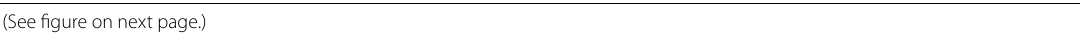
of variable appearance. Figure 9C (left) depicts gray angu- lar blocks in a whitish matrix. The majority of the blocks measure less than 1 m. The matrix consists of commi- nuted limestone with a grain size 2 mm. The rock is a ≤ matrix-supported breccia and corresponds to a catacla- site. Its texture could be called “block-in-powder”. Locally these cataclasites are cut by faults (Fig. 9C, right), which express themselves by a white cohesionless fault gouge.